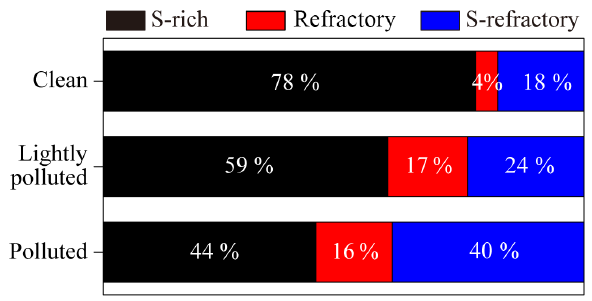
Figure 6. Number fractions of S-rich, refractory, and S-refractory particles at different pollution